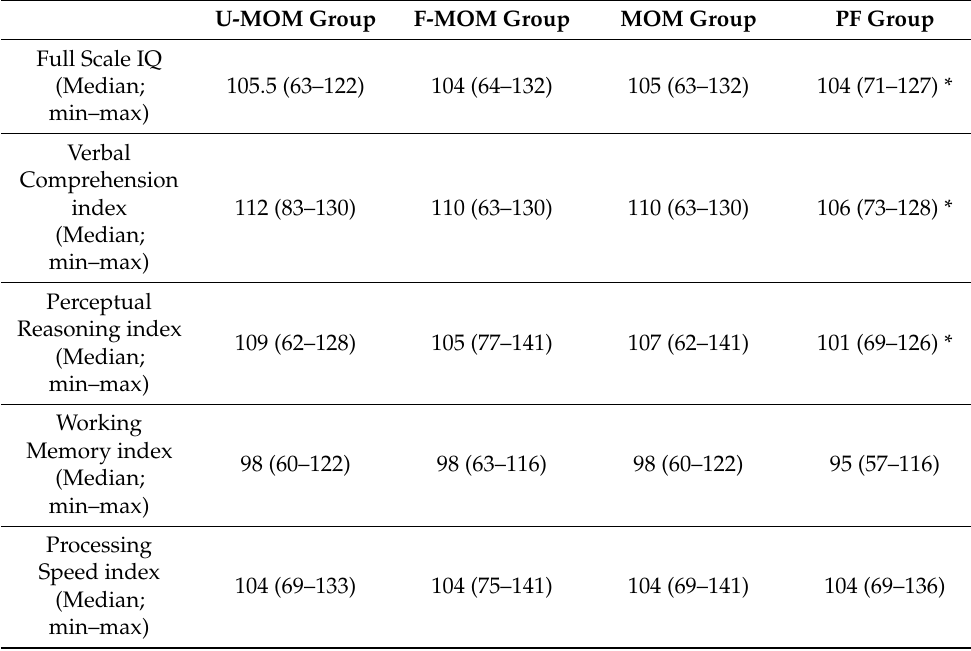
Table 2. Results of the WISC-IV